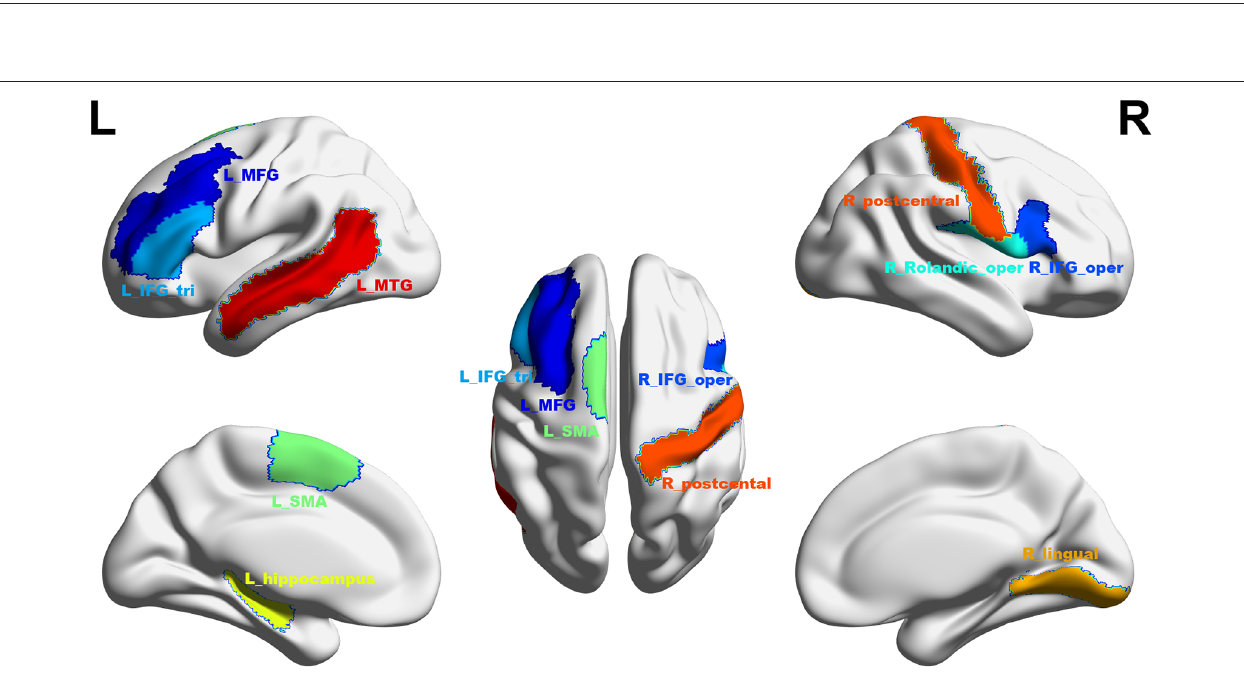
FIGURE 5 | The final selected regions at threshold p < 0.05. Nine regions were selected: L_MFG, left middle frontal gyrus (shown in dark blue); R_IFG_oper, pars opercularis of right inferior frontal gyrus (blue); L_IFG_tri, pars triangularis of left inferior frontal gyrus (sky blue); R_Rolandic_oper, pars opercularis of right rolandic area (cyan); L_SMA, left supplementary motor area (mint green); L_hippocampus, left hippocampus (yellow); R_lingual, right lingual gyrus (saffron yellow); R_postcentral, right postcentral gyrus (orange red); L_MTG, left middle temporal gyrus (red). L, left; R, right. This figure was constructed using the BrainNet Viewer (http://www.nitrc.org/projects/bnv/; Xia et al.,